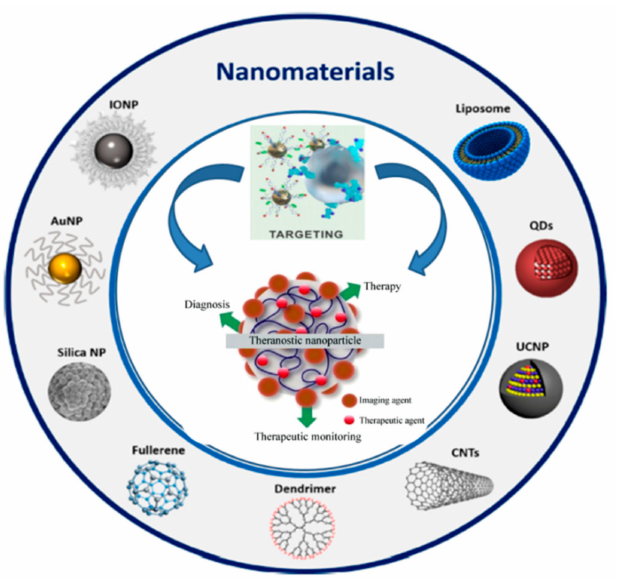
Figure 5. Schematic representation of the potential use of different radioconjugated nanomaterials in